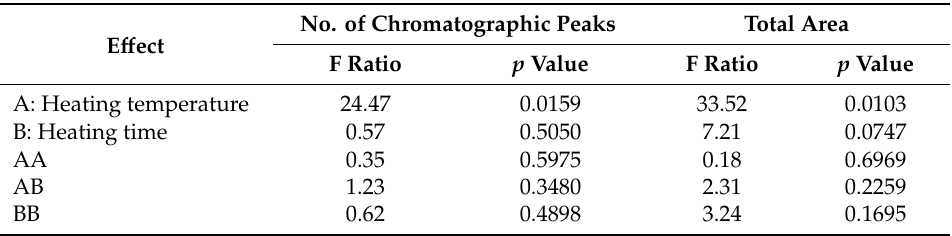
Table 6. Main e ff ects and interactions in the 3 2 factorial design for number of chromatographic peaks and total